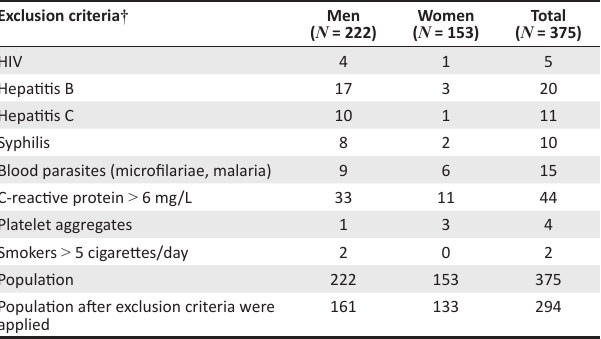
TABLE 1: Exclusion criteria applied to the study population in Yaoundé, Cameroon, November 2015 – September